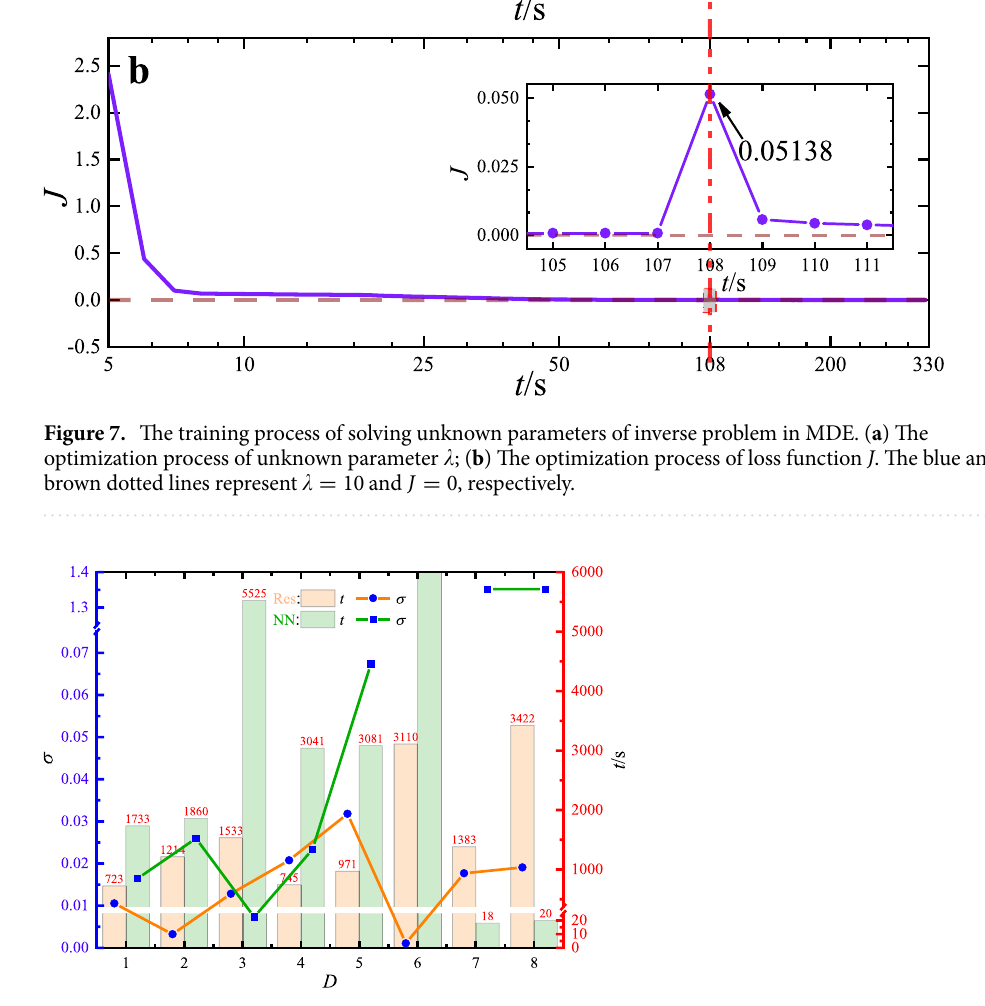
Figure 8. Comparison of training time ( t ) and standard error ( σ ) between PINN with residual units and traditional NN, Here, the width of neural network W is 20, data sampling number N is 20000, and the mixture coefficient of GLHS α is 0.5 in both cases. The yellow and green bars denote the training time t in the PINN and traditional NN cases, respectively, while the blue dots in the bars represent the corresponding standard error σ